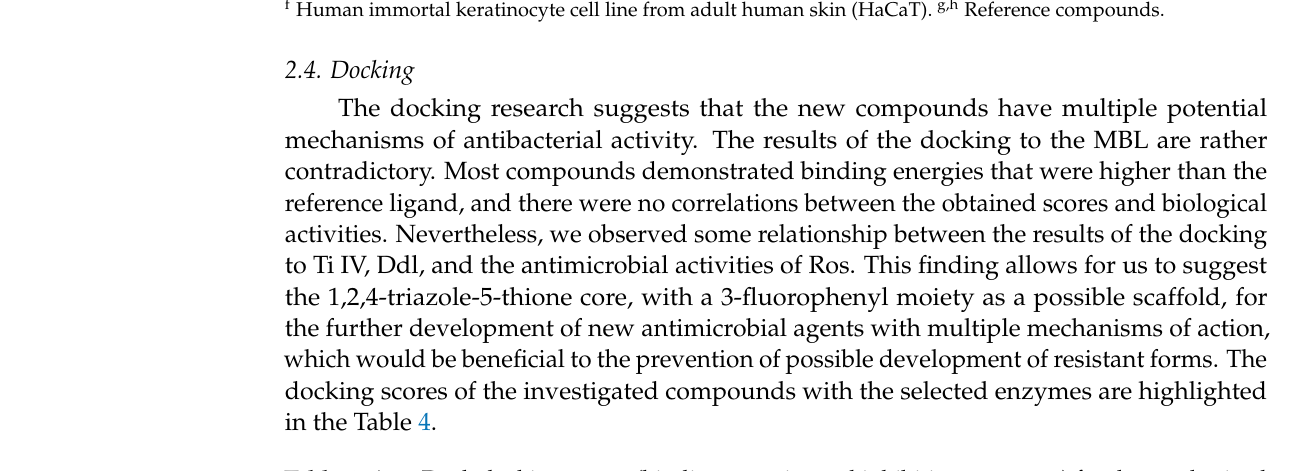
Table 4. AutoDock docking scores (binding energies and inhibition constants) for the synthesized